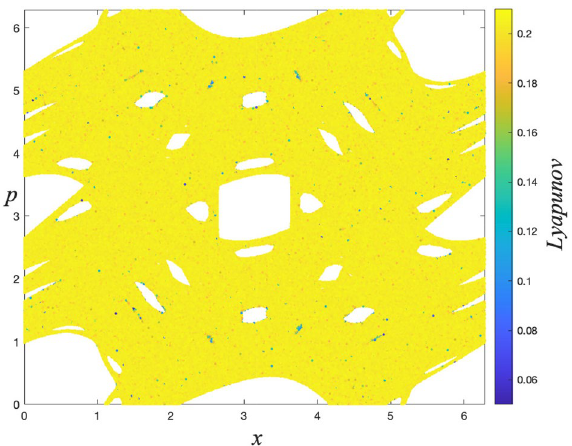
Figure 8. Discrimination of chaotic regions with different chaoticities that contribute two Gaussians to the probability distribution in the ( W = 2 , K = 0.4 ) system.